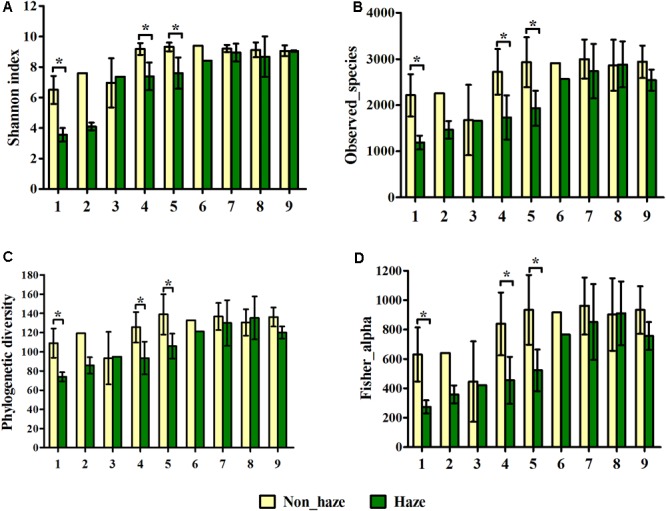
Shannon index (A), observed species (B), phylogenetic diversity (C) and fisher alpha (D) of bacterial community on haze and non-haze days in nine haze events during October 1, 2015, to January 5, 2016. Nos. 1–9 represent nine haze events. Yellow and green columns represent samples from non-haze and haze days, respectively. Error bars represent SD of samples from non-haze or haze days in each haze event, respectively. Non-haze samples in No. 2 and No. 6, and haze samples in No. 3 and No. 6, were not repeated because haze duration was too short in these haze events. T-test, ∗p < 0.05.